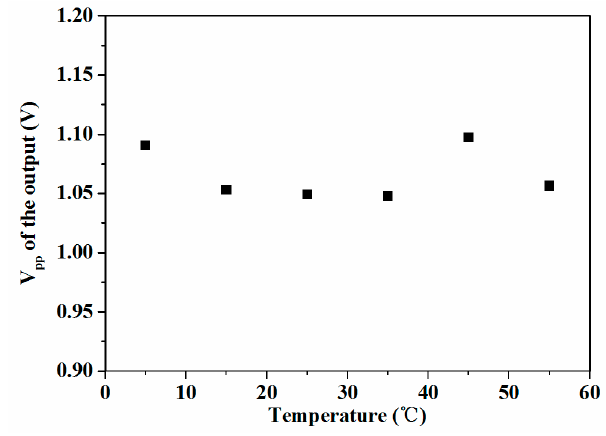
Figure 8. Response of the fabricated sensor with varying